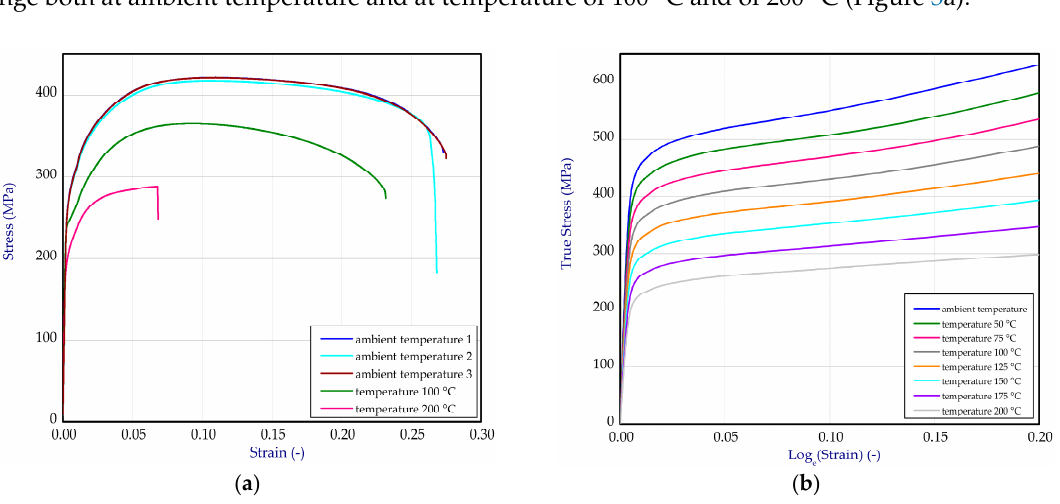
Figure 3. The tensile characteristics of titanium ( a ) and curves after transformation into true strain-stress relation ( b ).